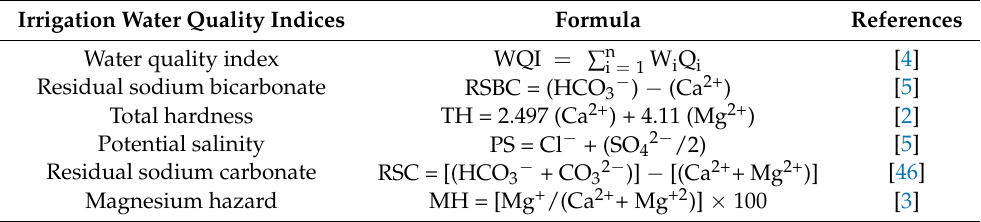
Table 1. Formula and references for different irrigation water quality indices applied in this